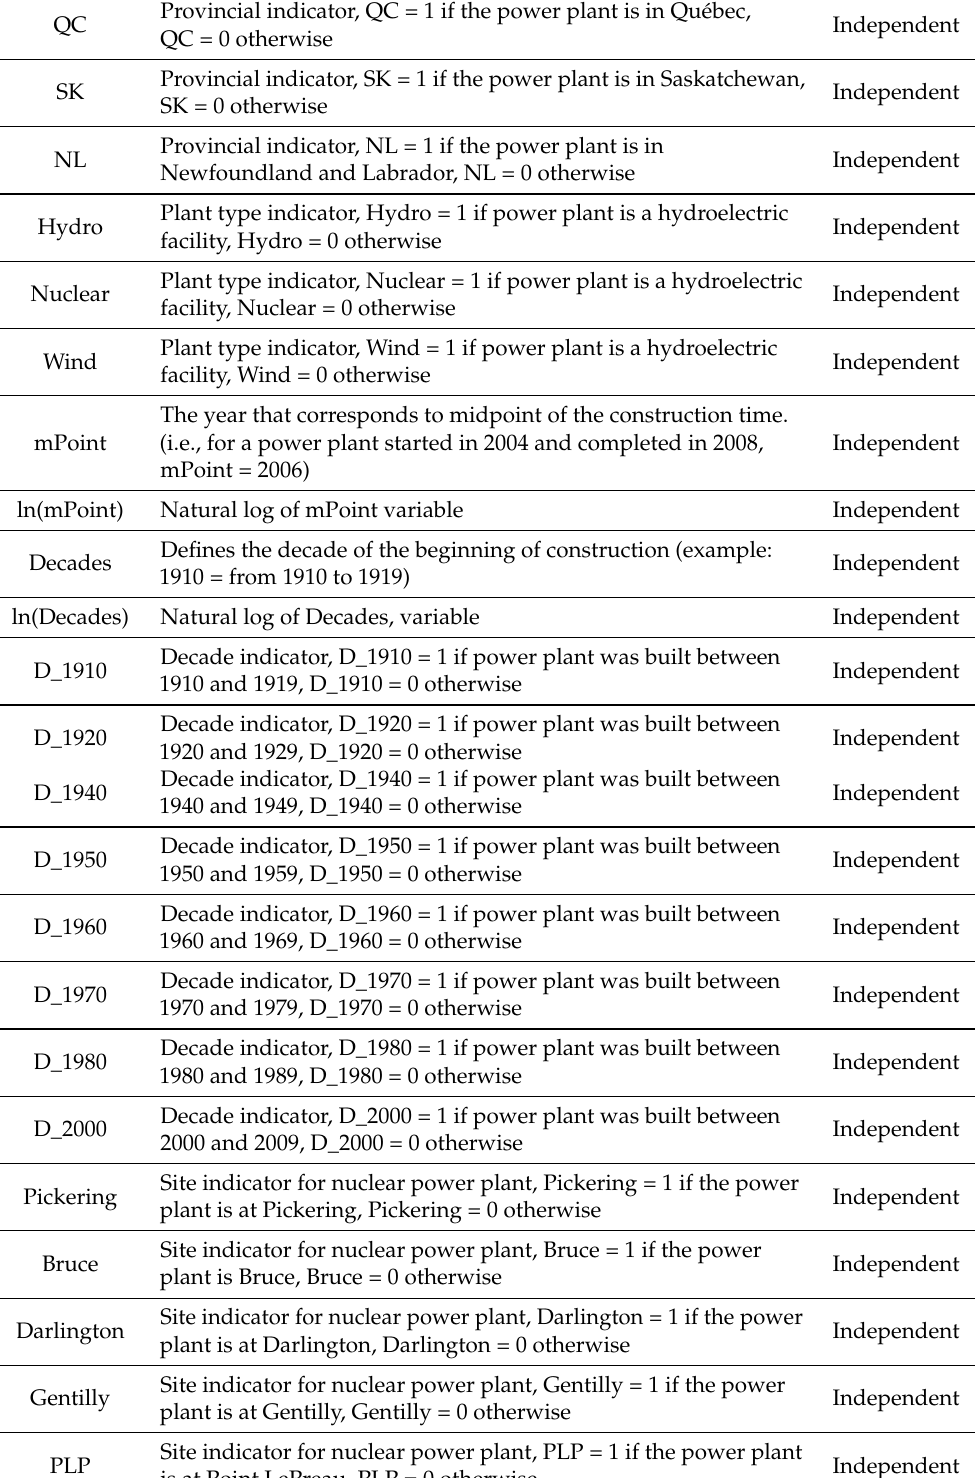
Independent Independent Independent